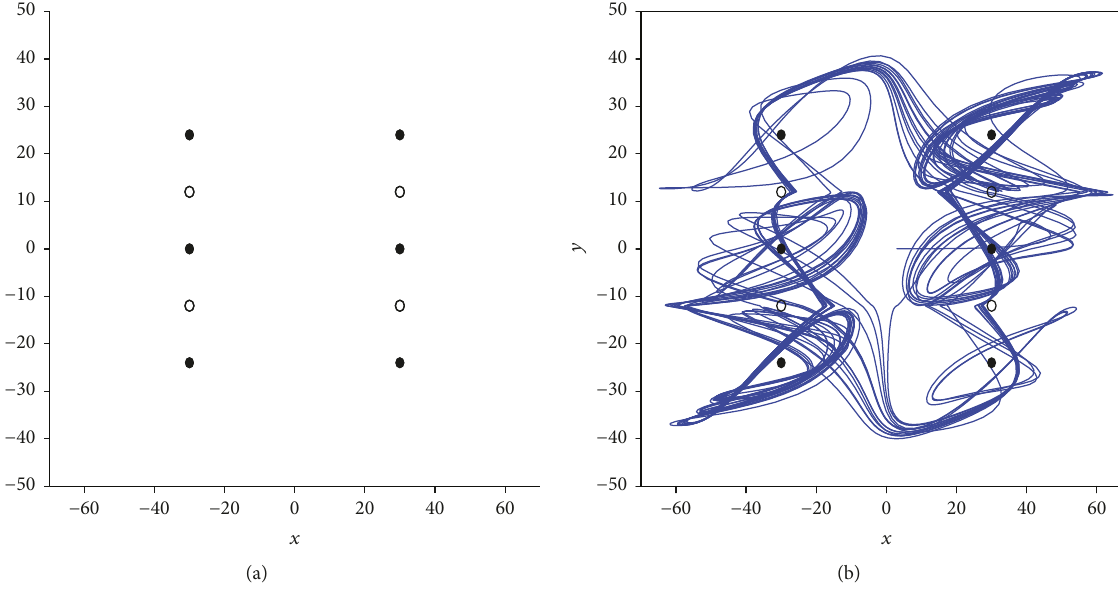
Figure 10: Equilibrium points and attractors of the 2 × 3 multiscroll hyperchaotic system. (a) Equilibrium points. (b) 2 × 3 multiscroll